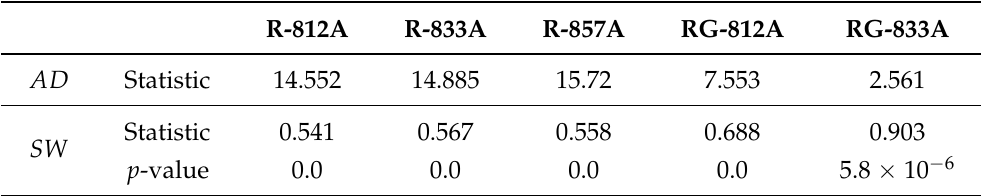
Table 1. The tests were performed under a given significance ( α ) of 5%. The critical value for AD test is 0.756. The prefixes R- and RG- stands for “RADAR” and “Rain Gauge”, respectively.